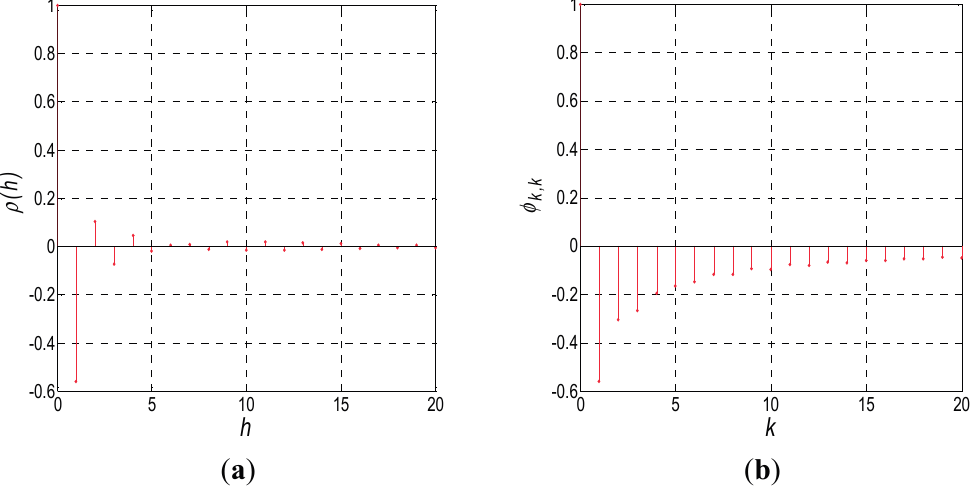
Figure 3. Self-correlation and partial correlation coefficient functions of VG951 random noise: ( a ) Self-correlation; ( b ) Partial